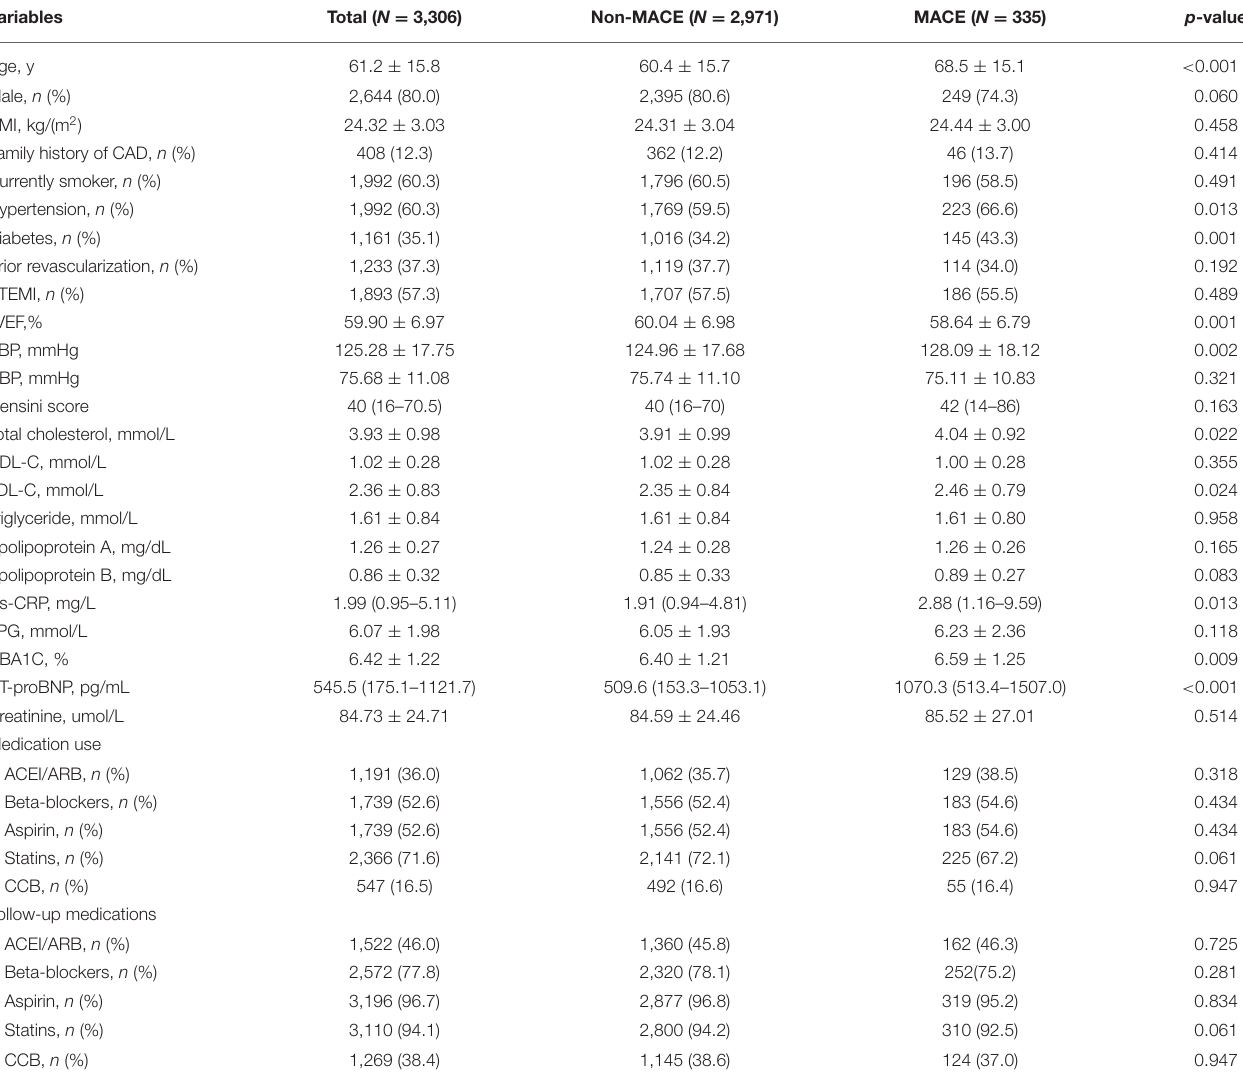
TABLE 1 | Baseline characteristics of study